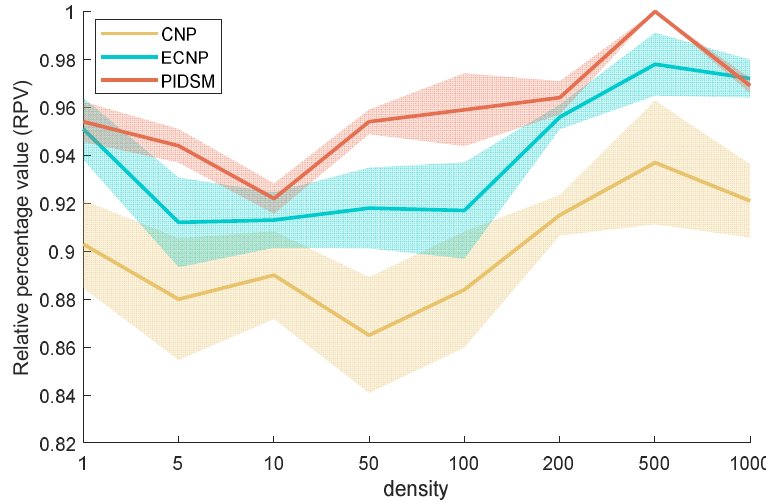
Figure 8. The impact of variation of the target distribution density on the performance of the algorithms.